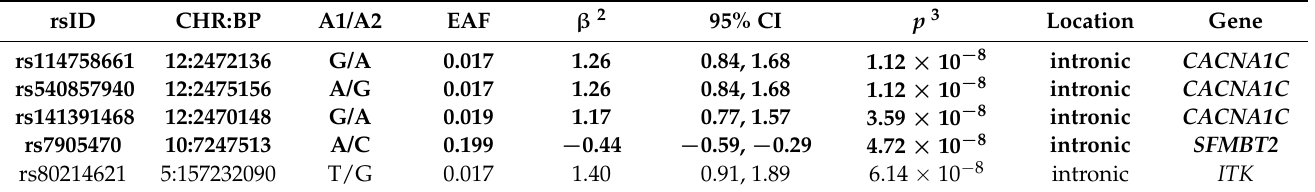
1 Abbreviations: rsID—reference snp cluster id; CHR—chromosome number; BP—base position from hg38 build; A1—effect allele; A2—allele 2; EAF—effect allele frequency; CI—confidence interval. 2 Associations are presented as standardized coefficients from additive genetic linear models. 3 Genome-wide significance p < 5.00 × 10 − 8 ( bold